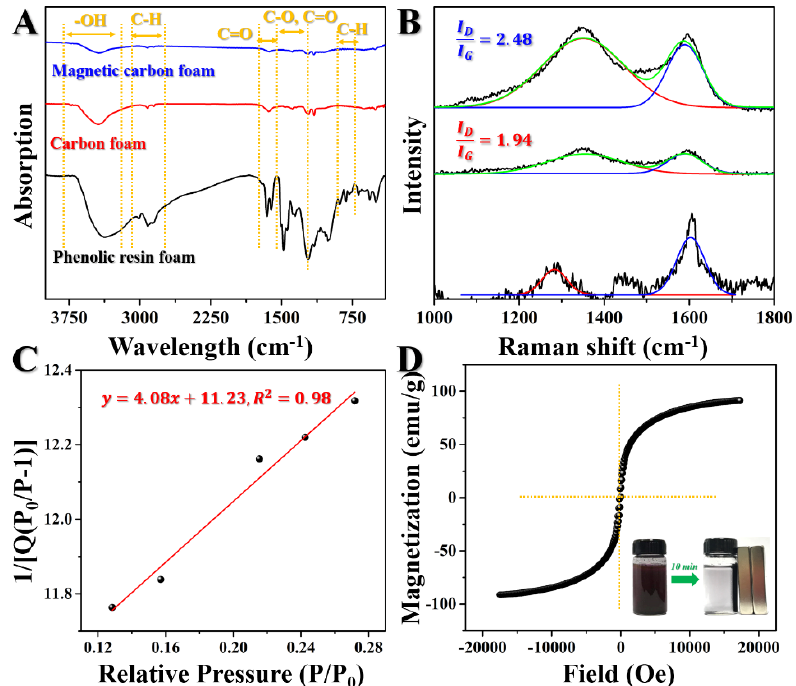
Figure 4. ( A ) FT-IR curves of phenolic resin foam (black), carbon foam (red), and magnetic carbon foam (blue), respectively. ( B ) Raman curves of phenolic resin foam, carbon foam, and magnetic carbon foam, respectively. ( C ) The five-point BET surface area analysis for magnetic carbon foam. ( D ) VSM curve of magnetic carbon foam. Insert : Mixed solution of RhB and magnetic carbon foam before and after 10 min magnetic separation.